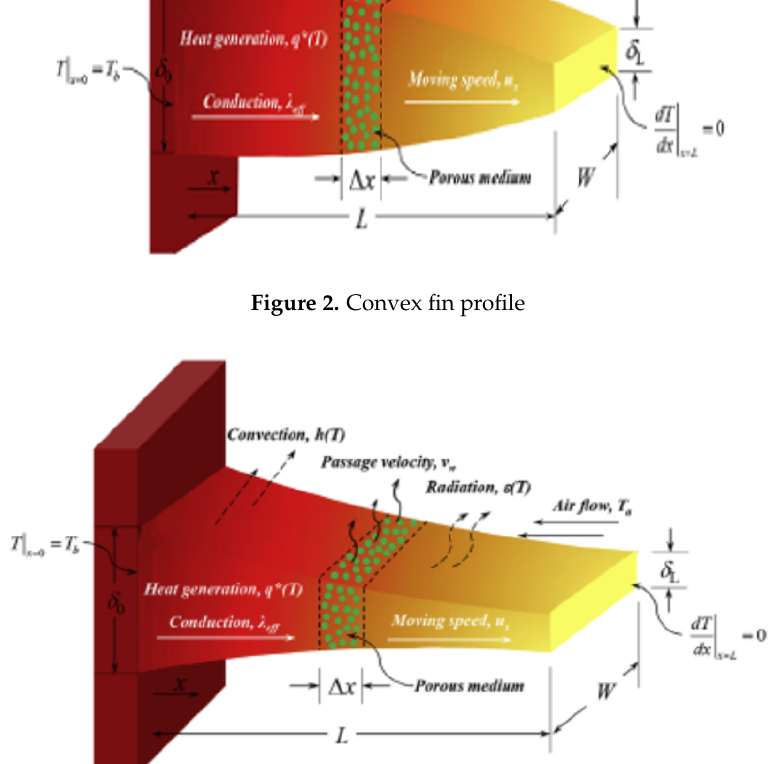
Figure 3. Concave fin